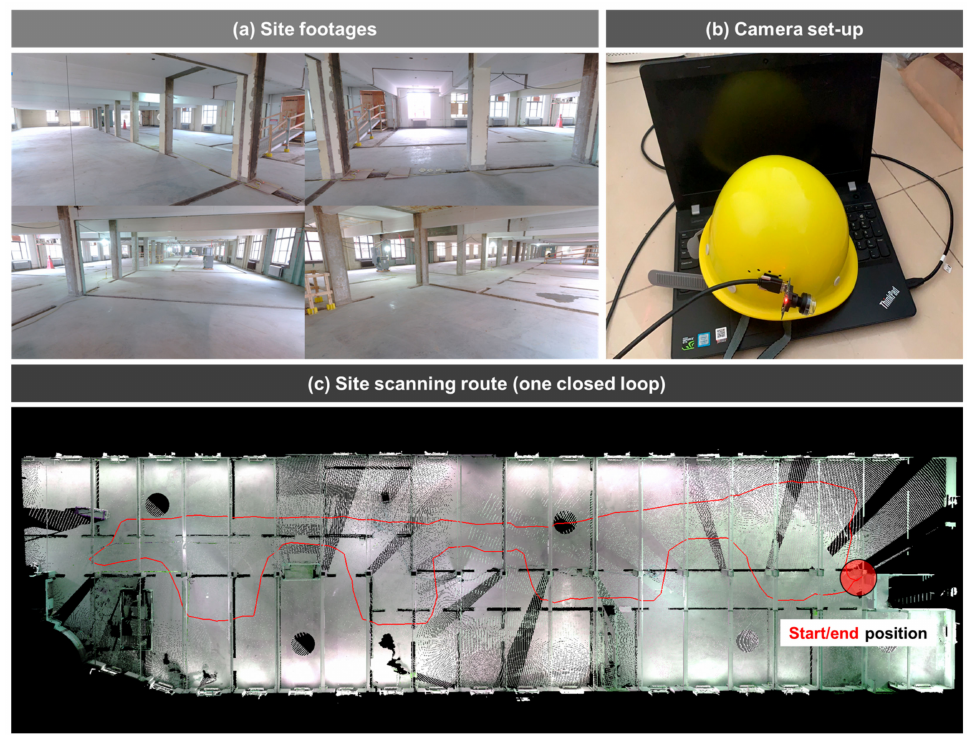
Figure 6. Test setting: site footages and camera